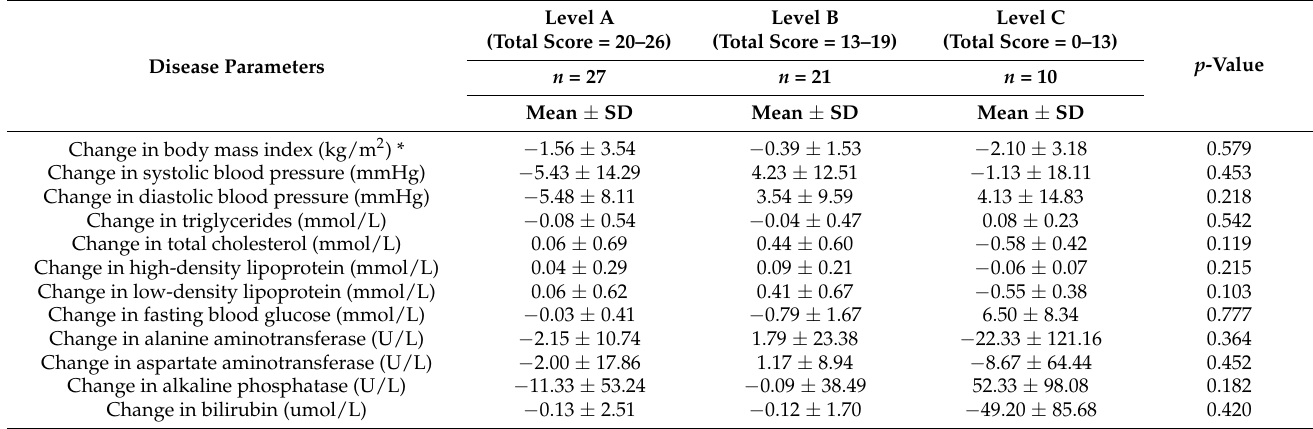
Table 6. Effect of dietitian documentation level on disease parameters in subjects with reported dietitian documentation among the entire study